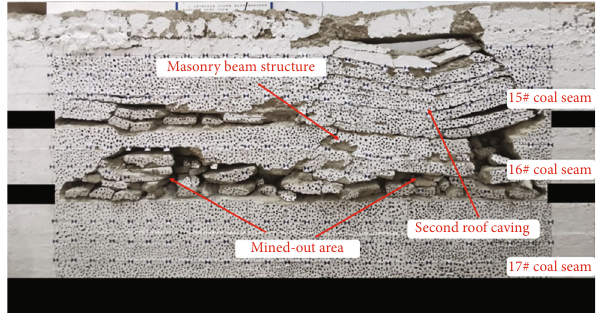
Figure 5: Characteristics of overlying strata collapse.